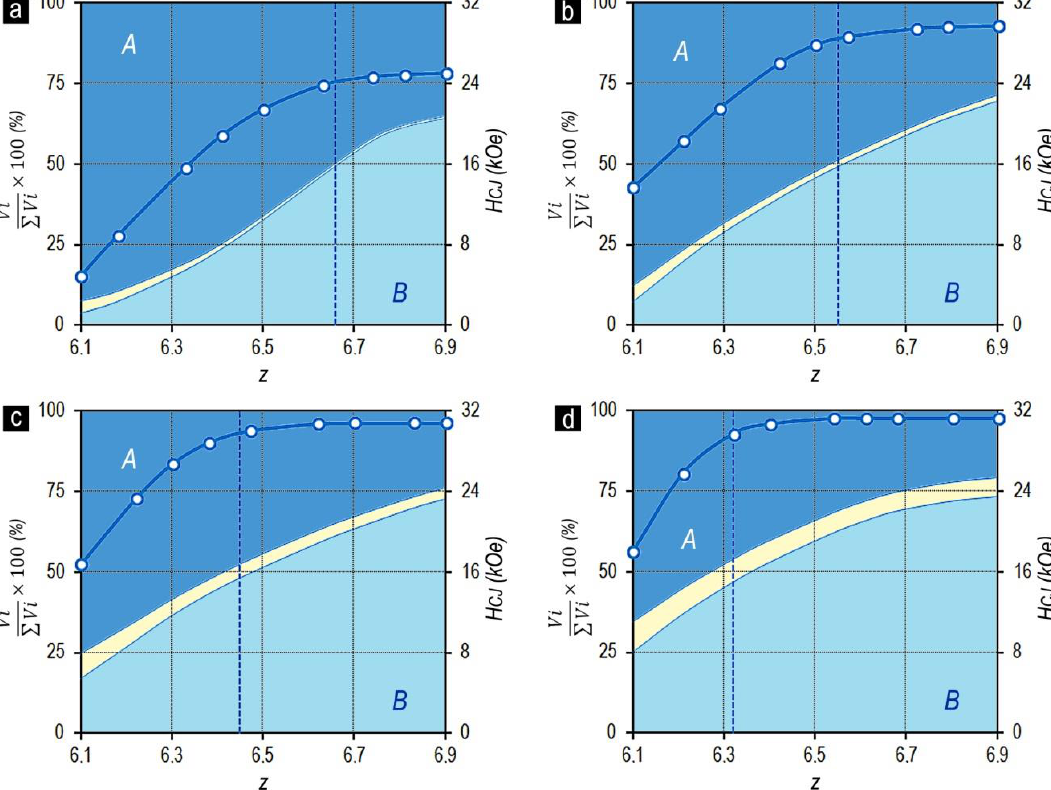
Figure 6. Dependences of the volume percentage of structural components A, B, and C ((V i / Σ V i ) × 100) and coercive force (H CJ ) of the Sm 1-X Zr X (Co 0.702 Cu 0.088 Fe 0.210 ) z alloys with x = 0.13 ( a ), 0.15 ( b ), 0.17 ( c ), and 0.19 ( d ) on the chemical composition z. The vertical dashed line shows the compositions with equal volume percentage of structural components A and B.